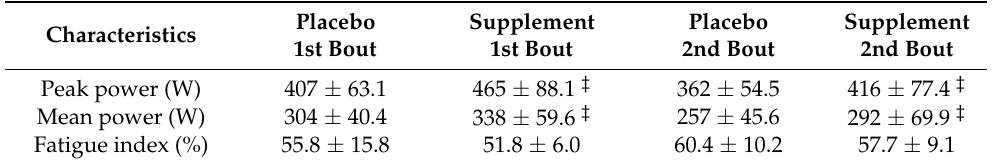
Table 2. Mean ( ± SD) values of power indices ( N =